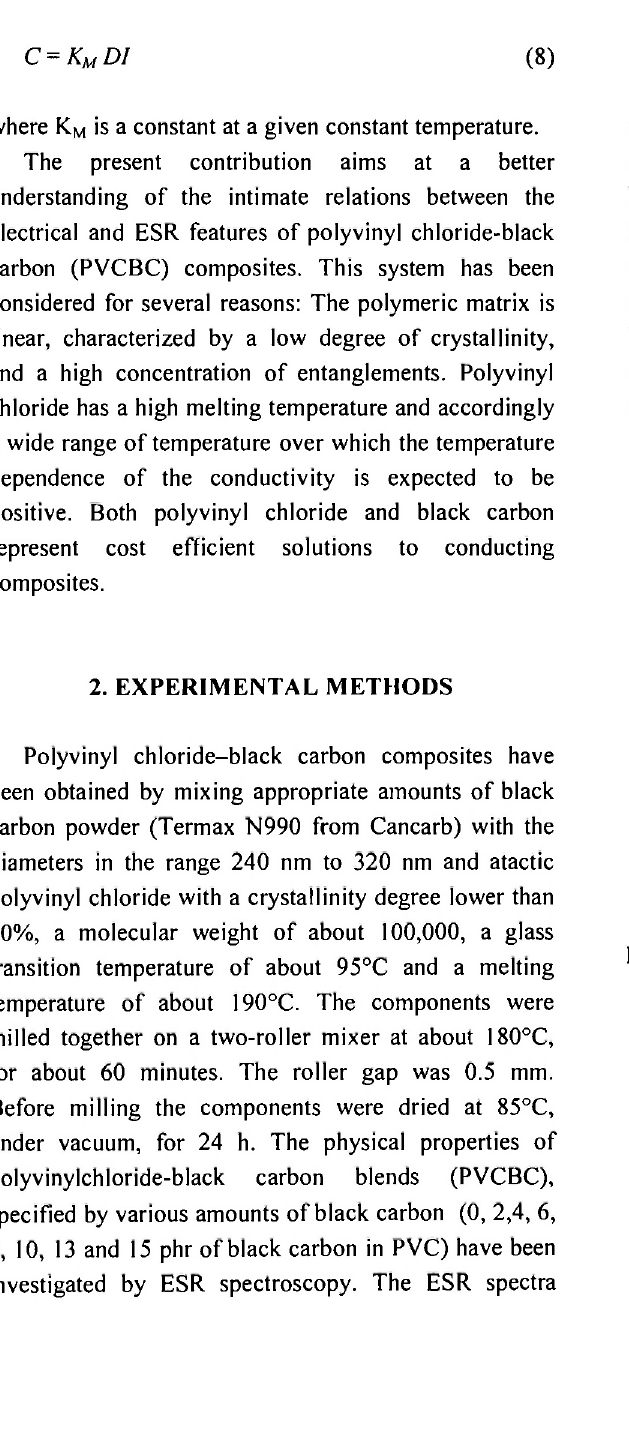
Fig. 1: A. ESR spectrum at polyvinyl chloride black carbon composite (4% phr black carbon), at room